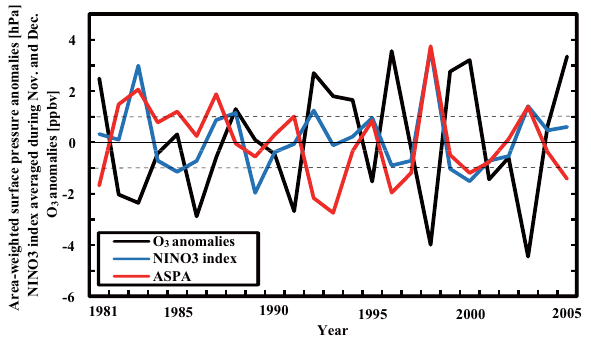
Fig. 10. Time series of springtime BL O 3 anomalies over WCJ, ASPA, and the Ni˜no3 index (NINO3) averaged during November and December of the previous year. Horizontal dashed lines indi- Figure 10. Time series of springtime BL O 3 anomalies over WCJ, ASPA, and the Niño3 972 cate ± 1hPa of ASPA. The simulation scenario and the definition of index (NINO3) averaged during November and December of the previous year. 973 anomalies are the same as in Fig. Horizontal dashed lines indicate ±1 hPa of ASPA. The simulation scenario and the 974 definition of anomalies are the same as in Fig. 6. 975